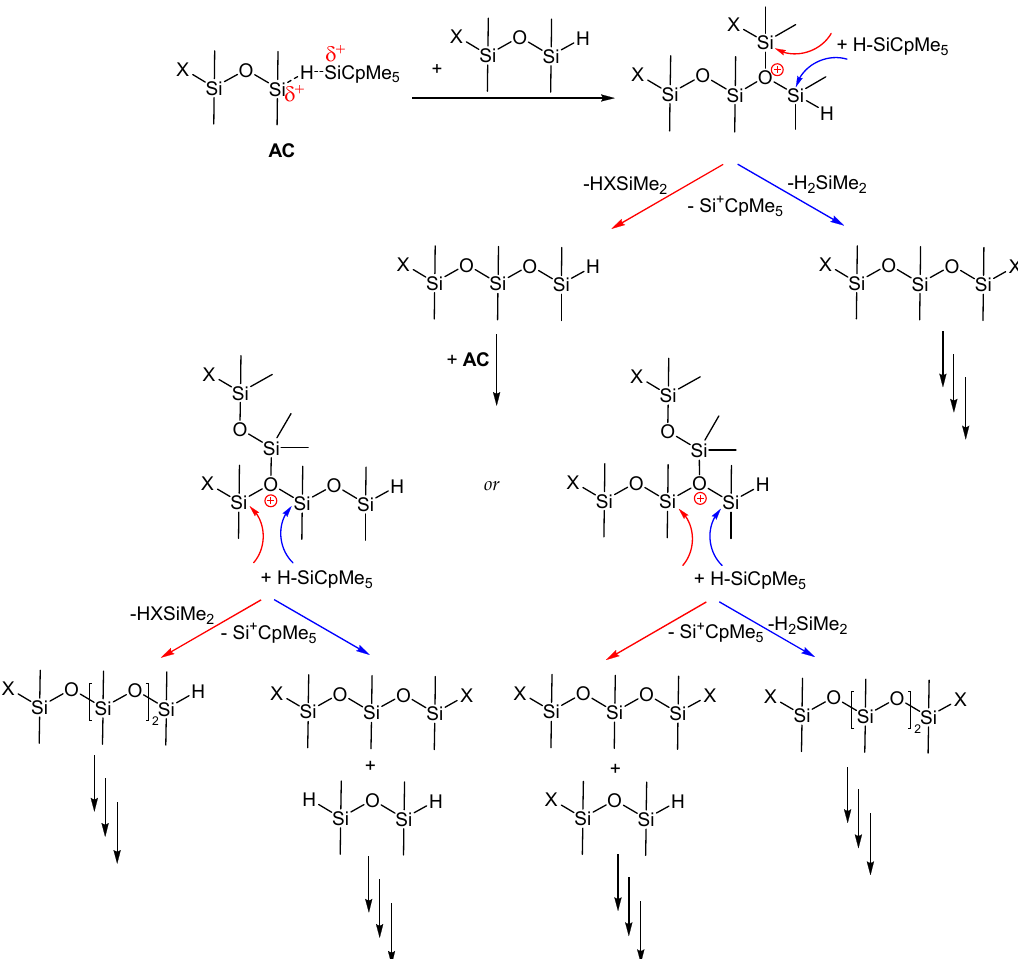
Scheme 9. Proposed mechanism for the redistribution of siloxanes with terminal Si ‐ H groups 5a (X = Me) and 5b (X =